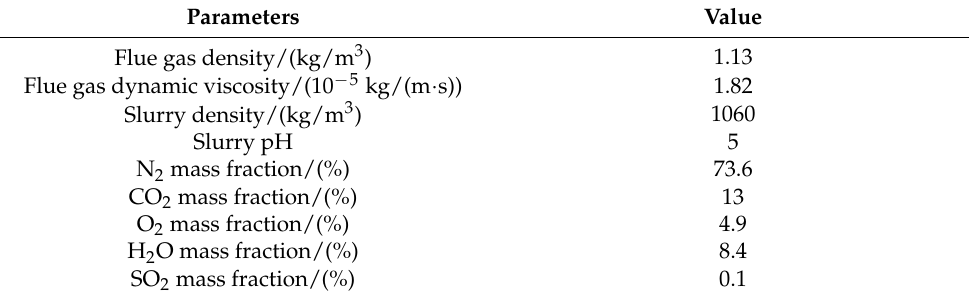
Table 1. Flue gas and slurry parameters.